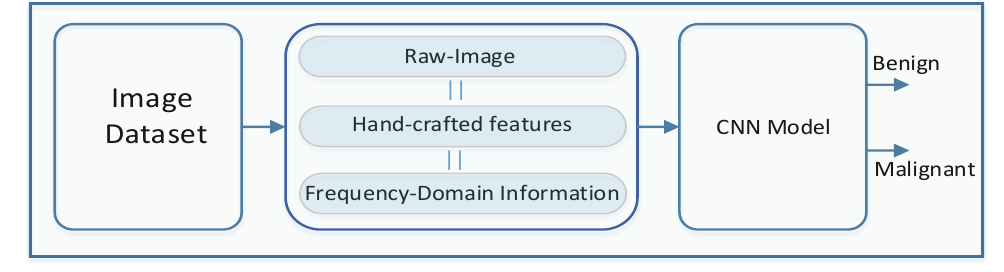
Figure 3. Overall image classification